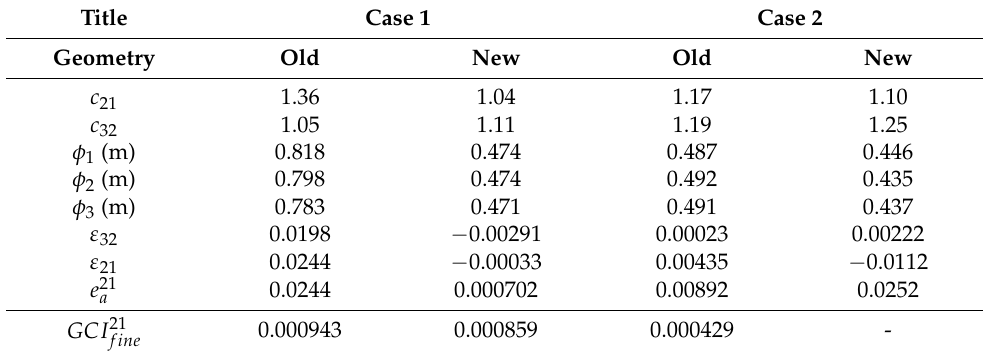
Table 4. Spatial discretization error and numerical uncertainties in spiral case and tandem